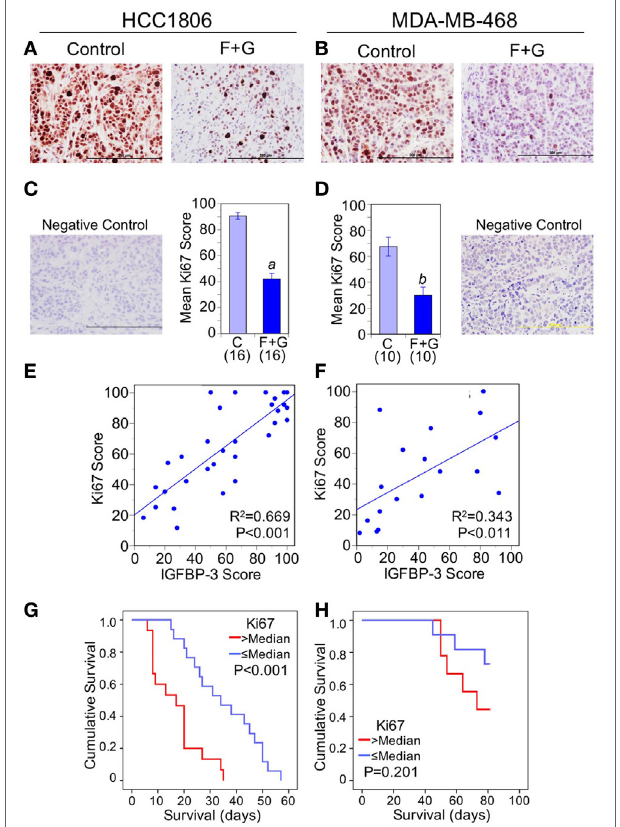
FigUre 4 | The relationship between tumor Ki67 and mouse survival. (a,B) Representative Ki67 staining of each tumor type from control mice and mice treated with fingolimod + gefitinib (F + G). (c,D) Quantitation of immunohistochemistry (IHC) scores for Ki67 in control and combination- treated mice. For HCC1806 (c) and MDA-MB-468 (D) tumors, mean scores ± SEM are shown, numbers of mice in parentheses. Comparison with controls (2-sided t -test): ( a ) P < 0.001; ( b ) P = 0.001. Also shown are IgG isotype negative staining controls for both tumor types. (e,F) Nuclear insulin-like growth factor binding protein-3 scores are positively correlated with Ki67 scores for both HCC1806 (e) and MDA-MB-468 (F) tumors. Linear regression lines are shown with R 2 and P values indicated. (g,h) Kaplan–Meier survival curves compare the effect of tumor Ki67 IHC scores > or ≤ the median value on survival of mice bearing HCC1806 (g) or MDA-MB-468 (h) xenograft tumors. For ethical reasons mouse survival is defined as tumor size below 1,000 mm 3 . For HCC1806, n ( > median) = 15; n ( ≤ median) = 17. For MDA-MB-468, n ( > median) = 9; n ( ≤ median) = 11.